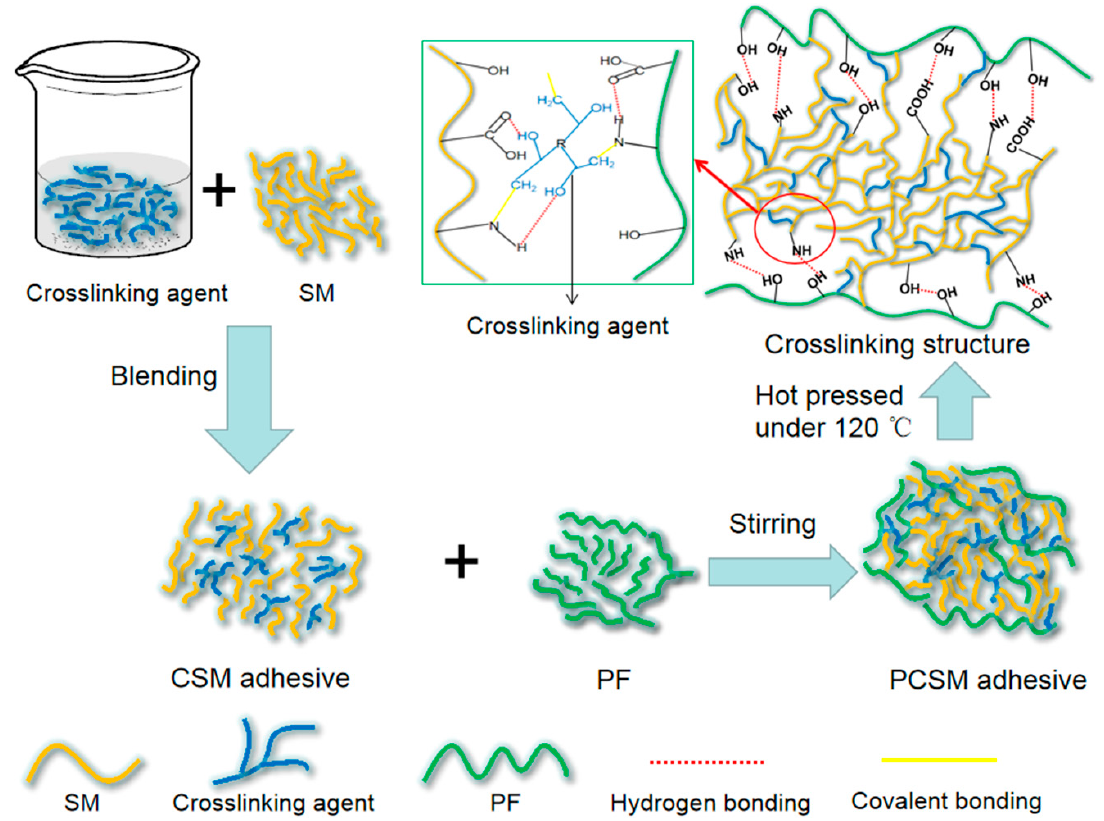
Scheme 1. Schematic illustration of the PCSM adhesive crosslinking